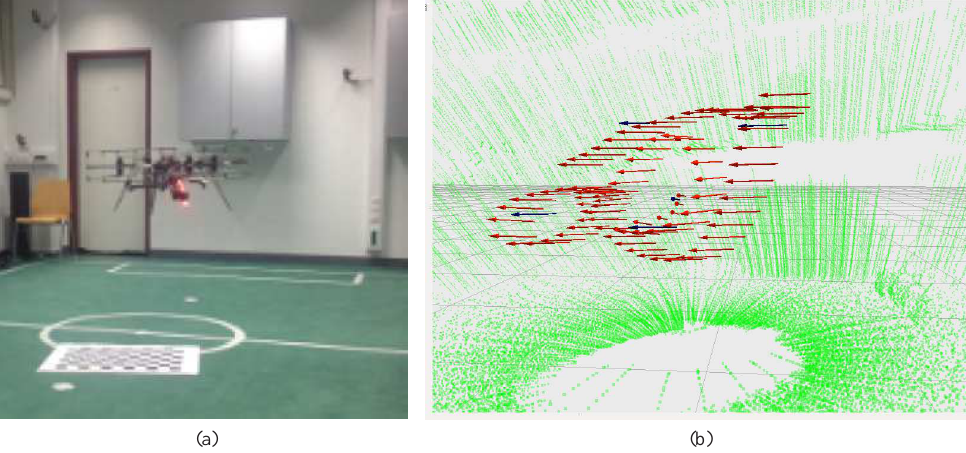
Figure 9: Evaluation of the scan registration in our motion capture system. (a) Setup. (b) Trajectory estimated by the algorithm (blue arrows) compared to the motion capture trajectory (red arrows).